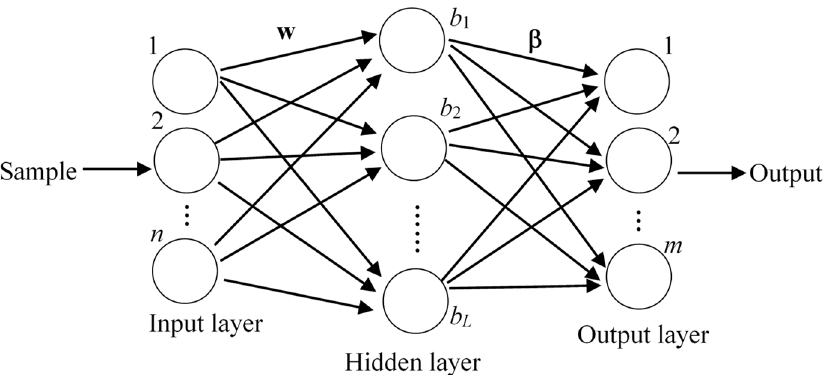
Figure 5. The structure of single hidden layer feed-forward neural network.